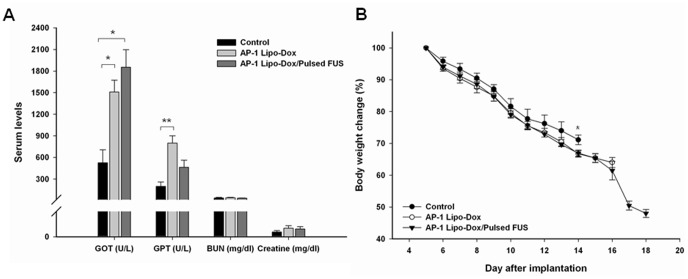
Systemic toxicity of AP-1 Lipo-Dox in tumor-bearing mice.(a) Serum chemistry of mice treated with AP-1 Lipo-Dox without or with sonication. The control tumor group received phosphate-buffered saline. Mice received treatments on days 5 and 9 after implantation. All animals were sacrificed for toxicity evaluation on day 12 after implantation. GOT = glutamic oxaloacetic transaminase, GPT = glutamic pyruvic transaminase, BUN = blood-urea nitrogen; *
p<0.05, **
p<0.01. (b) Mean body weights (relative to day 5) of tumor-bearing mice treated with AP-1 Lipo-Dox with or without sonication.